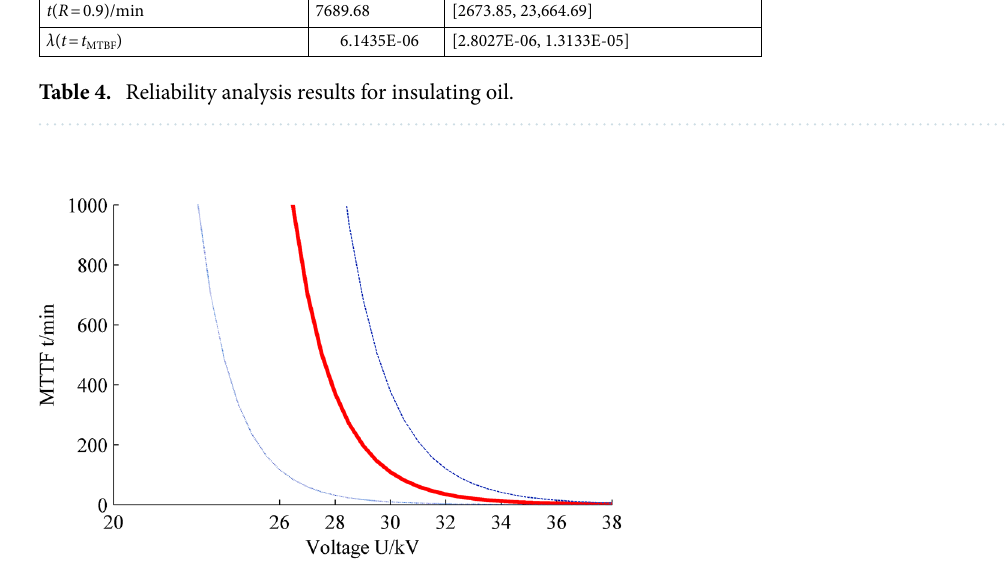
Figure 2. Interval estimation of MTTF. Figure created using Matlab R2014a (https:// www. mathw orks.